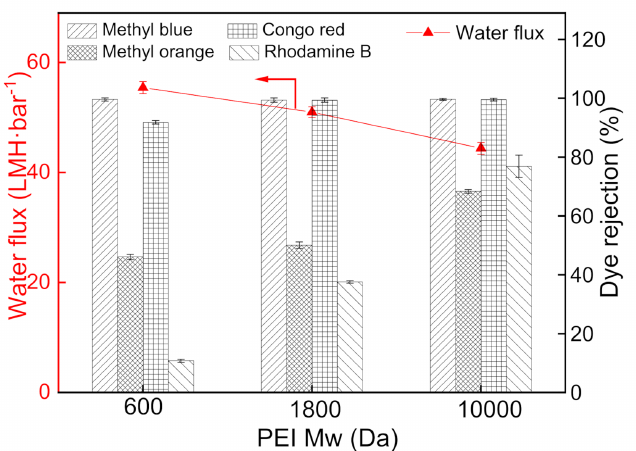
Figure 10. Influence of PEI molecular weight on the separation performance of PDA/PEI membranes (testing conditions: 2 bar, 25 ◦ C).